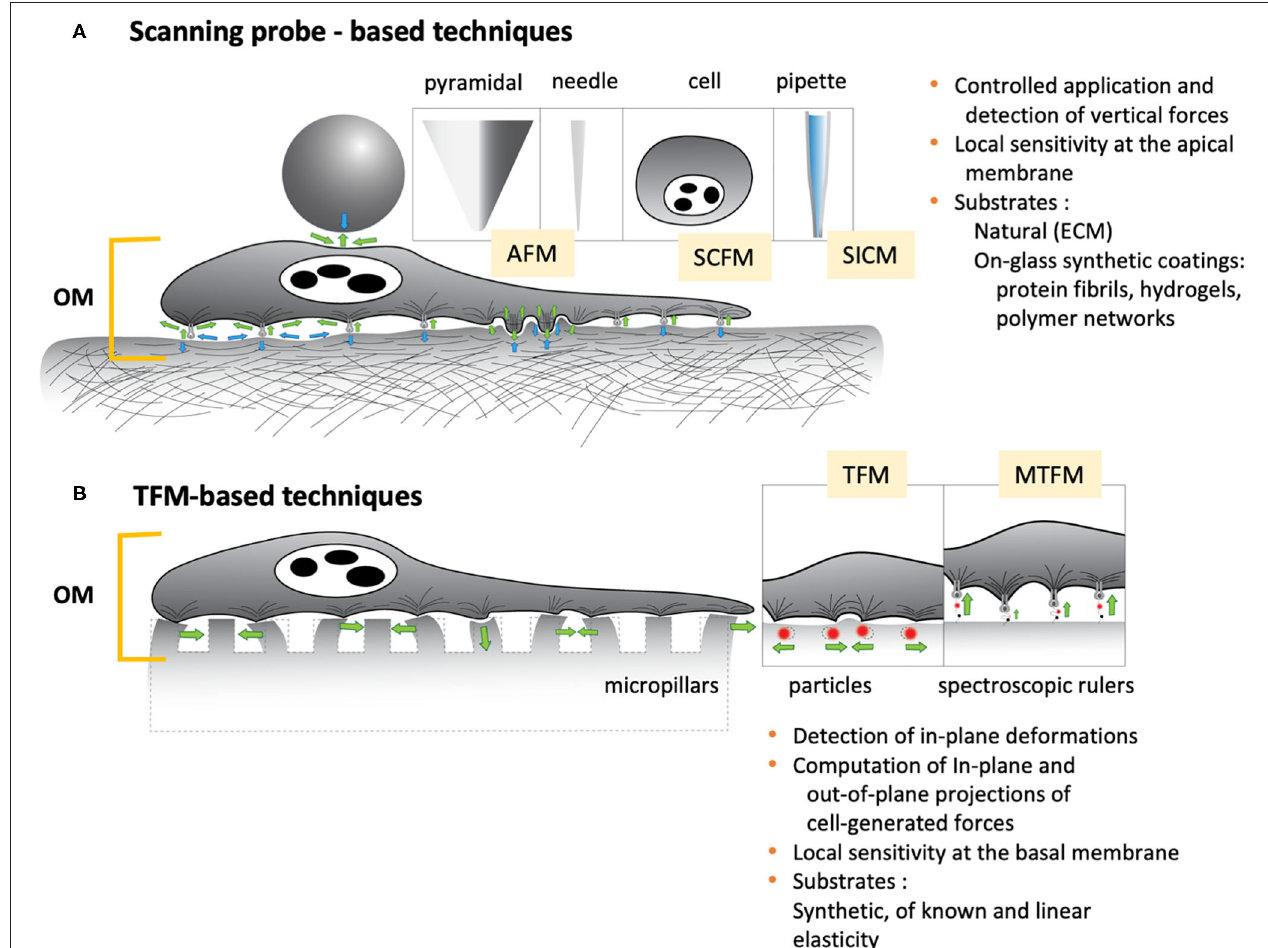
FIGURE 3 | Two of the most common contact-based technique to study cell mechanics. (A) Scanning probe-based techniques. Microbeads, pyramidal tips, needles, cells or pipettes are usually employed as stand-alone probes or attached to microcantilevers. (B) TFM-based techniques. Rigid materials or non-degradable silicone or polyacrylate are used as substrates, featuring micropillars, embedded fluorescent particles or spectroscopic rulers, i.e., fluorophore-quencher pairs attached to unfolding molecule (a repetitive protein construct, DNA hairpin, or PEG) that acts as a force sensor (Liu et al., 2017). Both sets of techniques heavily profit from or rely on the combination with optical microscopies. Green arrows: forces exerted by the cell; Blue arrows: exocellular